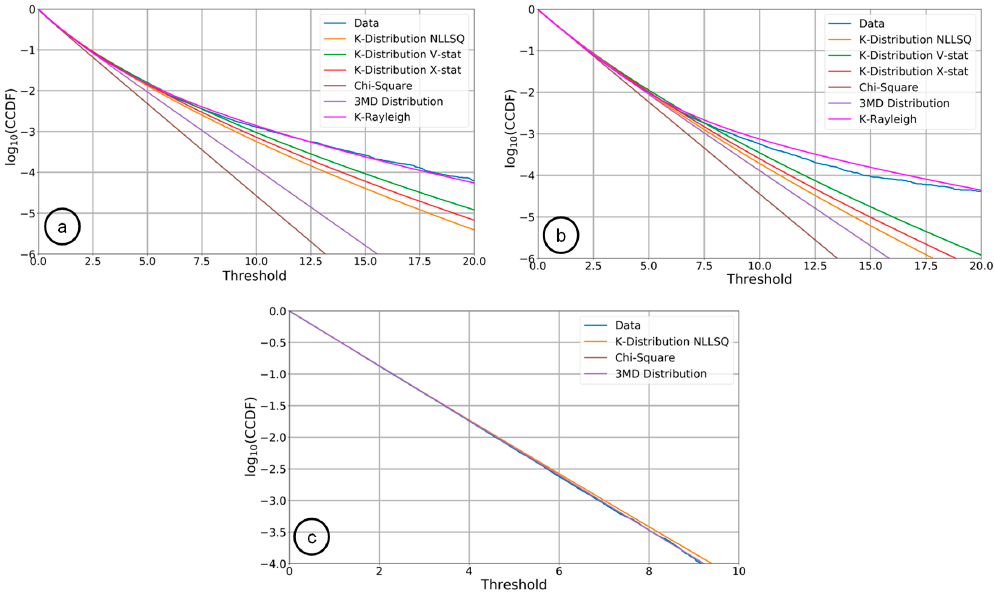
Figure 28. Logarithmic CCDFs of different distribution functions plotted for ( a ) near ( b ) mid and ( c ) far range. These plots are generated from the same data used for generating the plots shown in Error! Reference source not found. .